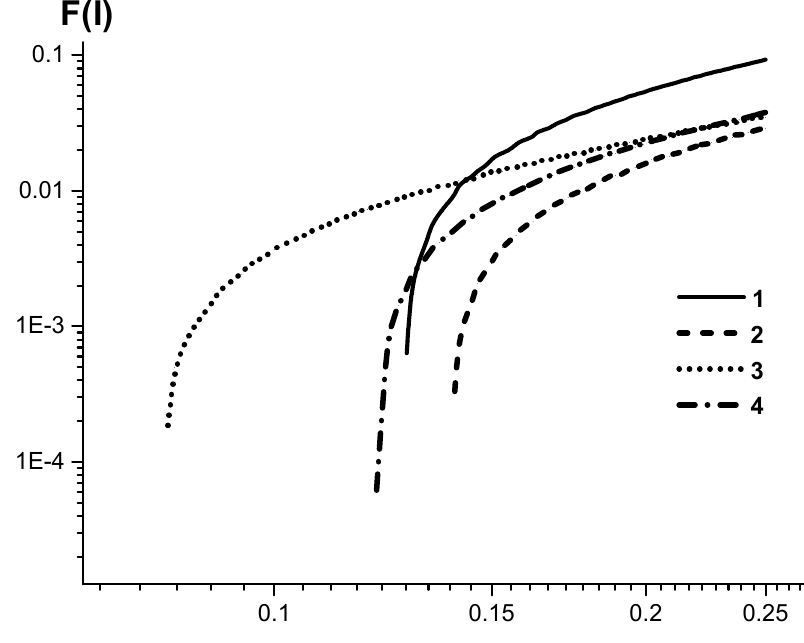
Figure 6. The same as shown in Figure 5, but the calibration curves are plotted by the conventional algorithm without accurate accounting for plasma background. The curves are plotted for: 1-SPAS-05 serial no. 18; 2, 3, 4-SPAS-02 serial numbers 22, 25,